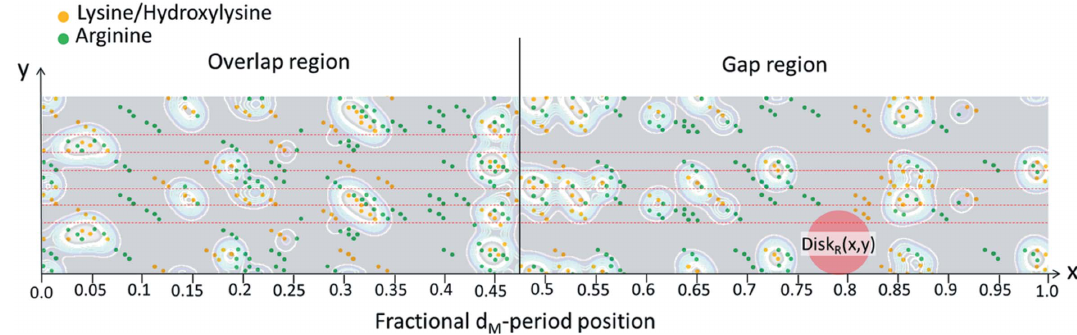
Figure 6 Likelihood for glycation. Shown is the 2D mapping of one period of the collagen structure (as in Fig. 4). The regions of the staggered repetition unit are denoted by dashed red lines. Superimposed is the probability function D arg–lys ( x , y ). The contours reveal where arginine (green bullets) and lysine/ hydroxylysine (orange bullets) are close to each other. At these positions the likelihood for glycation is high. The experimental resolution is indicated via a red disk, Disk R ( x , y ).